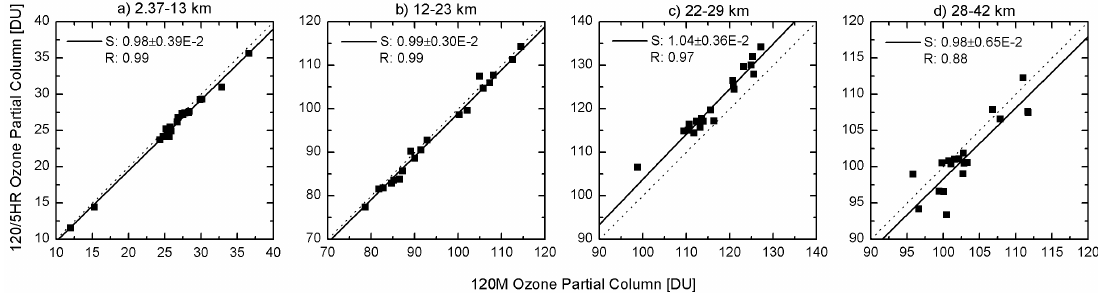
Fig. 6. Comparison between the IFS 120/5HR and IFS 120M ozone partial columns [DU] for the 120M-120/5HR coincidences during March and April 2005 ( N = 19) and for setup C: (a) 2.37–13km, (b) 12–23km and (c) 22–29km and (d) 28–42km. The black solid lines are the linear regression lines through origin, whose parameters are shown in the legend ( S is the slope of regression fit and R the correlation coefficient). The dotted lines are the